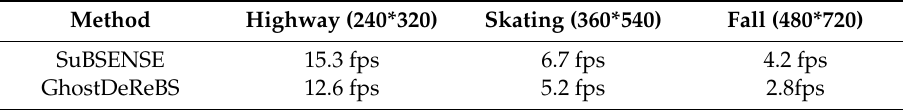
Table 9. Runtime comparison on three video sequences with di ff erent